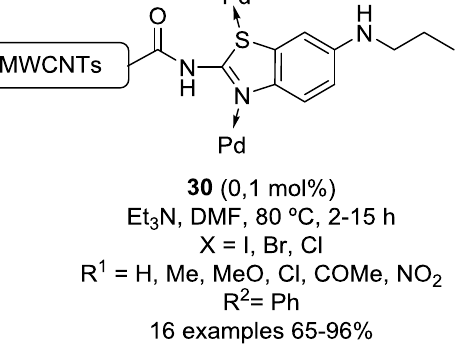
Figure 11. Palladium species immobilized on functionalized graphene oxide as catalysts for the Sonogashira reaction. Conditions, substrate scope and yield range (Scheme 2). 4. Functionalized Silica-Supported Palladium Catalysts The use of silica as a support for PdNPs has several advantages compared to other type of inorganics, since silica materials of several types, i.e., amorphous or mesoporous, are cheap and readily accessible, have good porosity, large surface area and chemical and mechanical stability. In addition, different functional groups can be anchored to the silica surface to effectively immobilize and stabilize PdNPs. This can minimize possible metal leaching and allows the easy recovery and